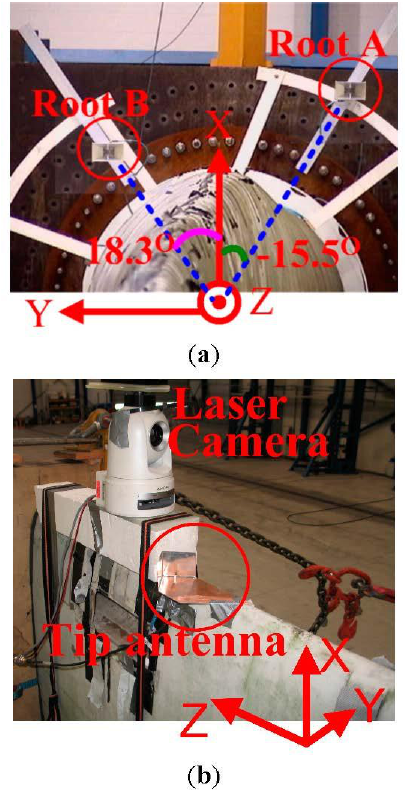
Figure 3. Locations of ( a ) root antennas and ( b ) tip